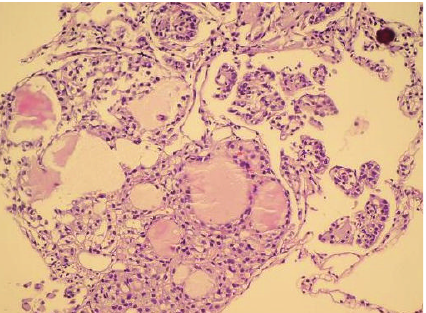
Figure 4: In a closer look, follicular and papillary structures, psammoma body, and intranuclear inclusions become visible as well (H&E ×